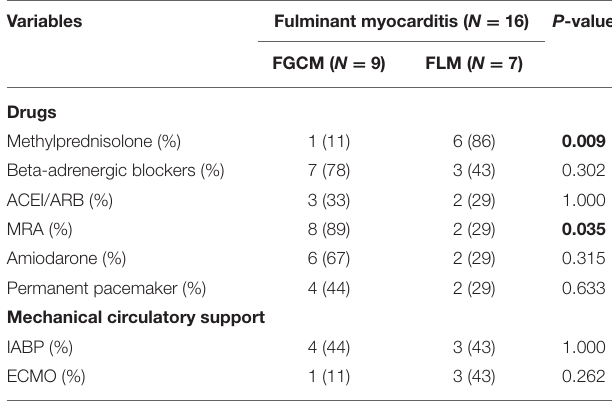
TABLE 2 | Comparison of treatments during hospitalization in patients with FGCM and FLM.